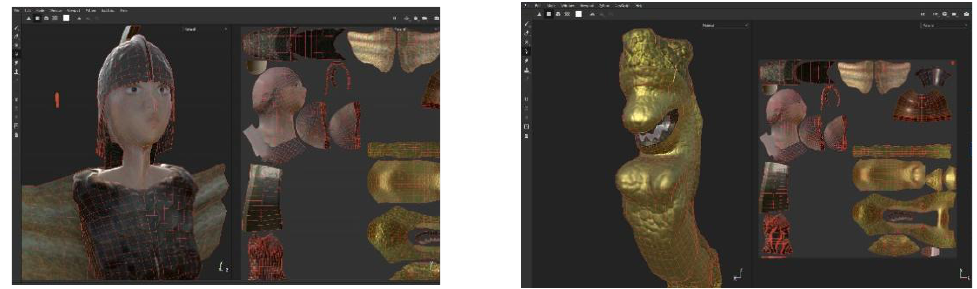
Figure 10 . Example of UV unwrapping. Texture created with Adobe Substance 3D